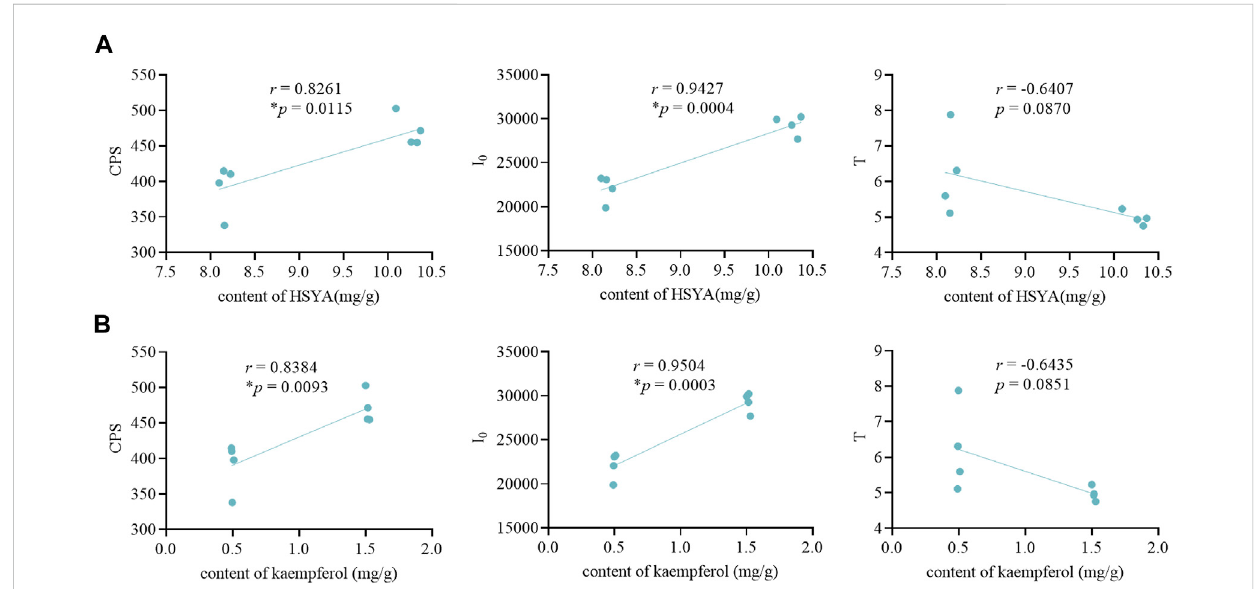
The correlation analysis of saf fl ower. (A) The correlation analysis between the content of HSYA and the biophoton parameters. (B) The correlation analysis between the content of kaempferol and the biophoton parameters.